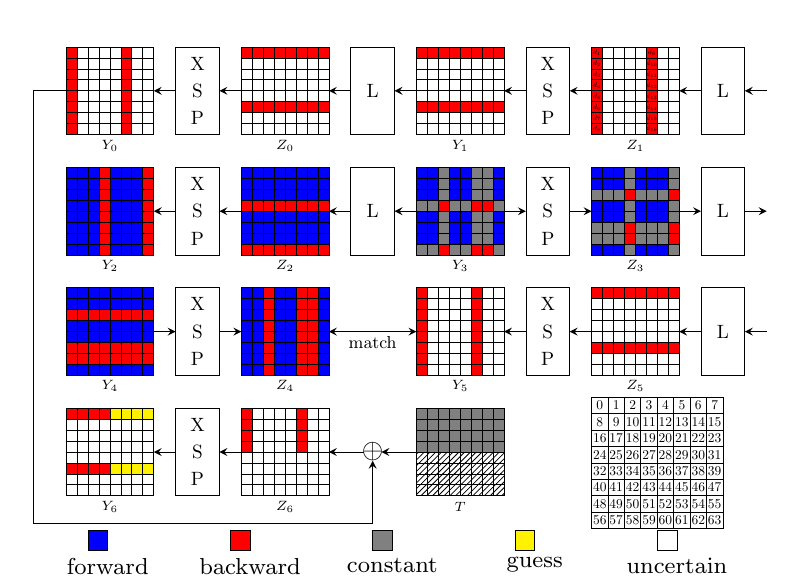
Figure 10: 6.5-round preimage attack on Streebog -256 compression function